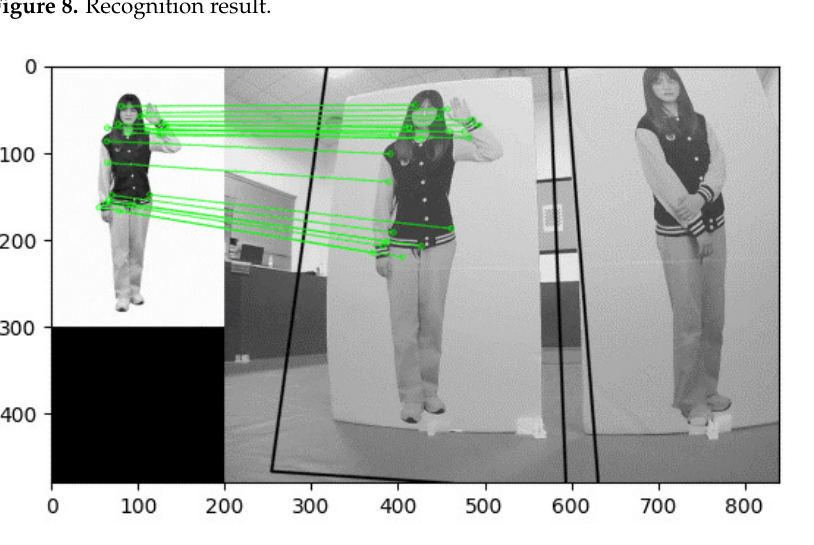
Figure 9. Feature